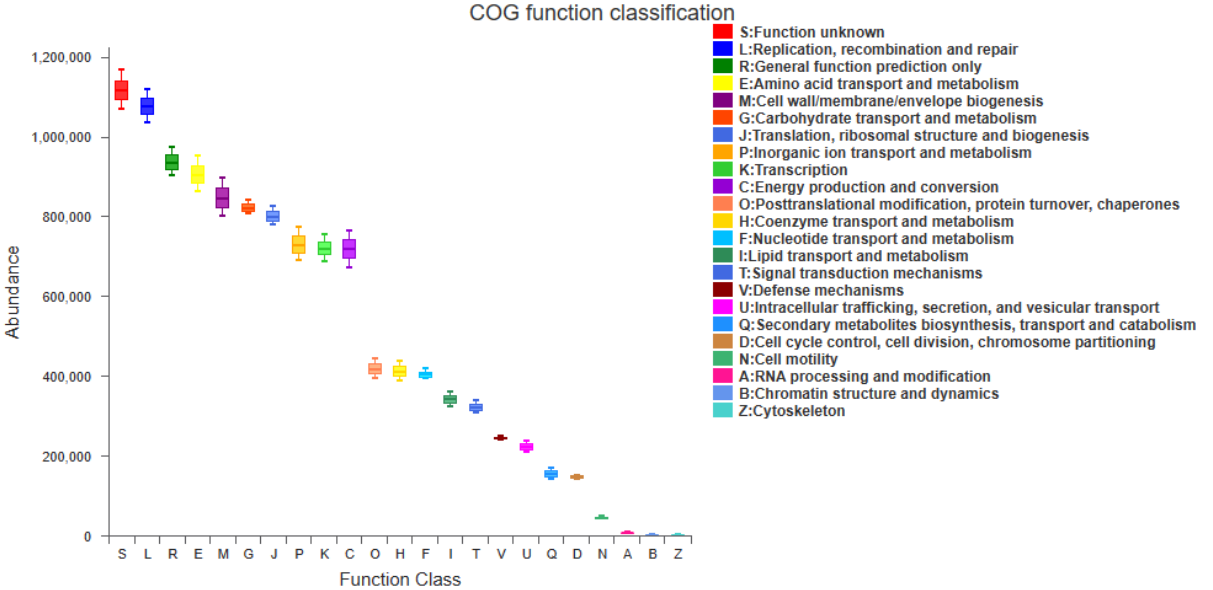
Figure 6. COG function annotation of bacterial OTU in fermented grains sample. Note: The abun- dance here refers to the functional abundance, that is, the number of genes in the OTUs corresponding to various predictive functions.